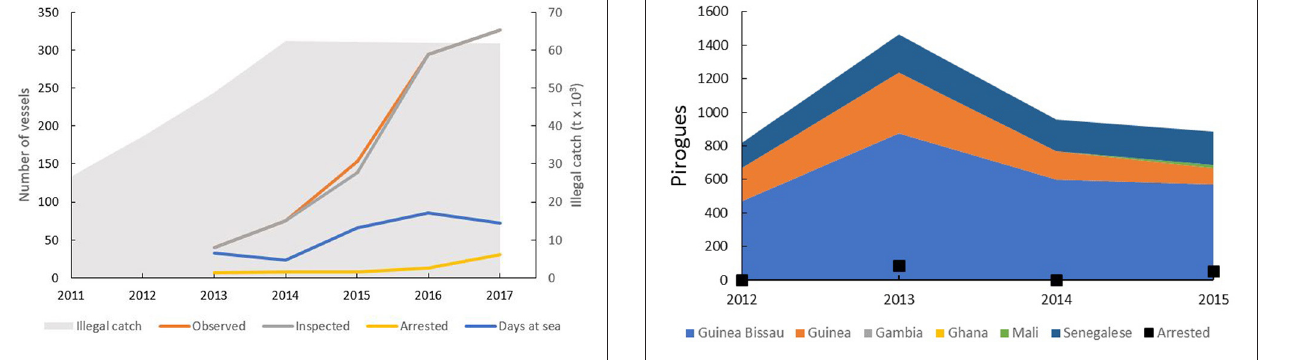
FIGURE 4 | Monitoring, Control and surveillance of industrial fisheries, results from Guinea Bissau, and the illegal catch within the EEZ of Guinea Bissau, 2013–2017.